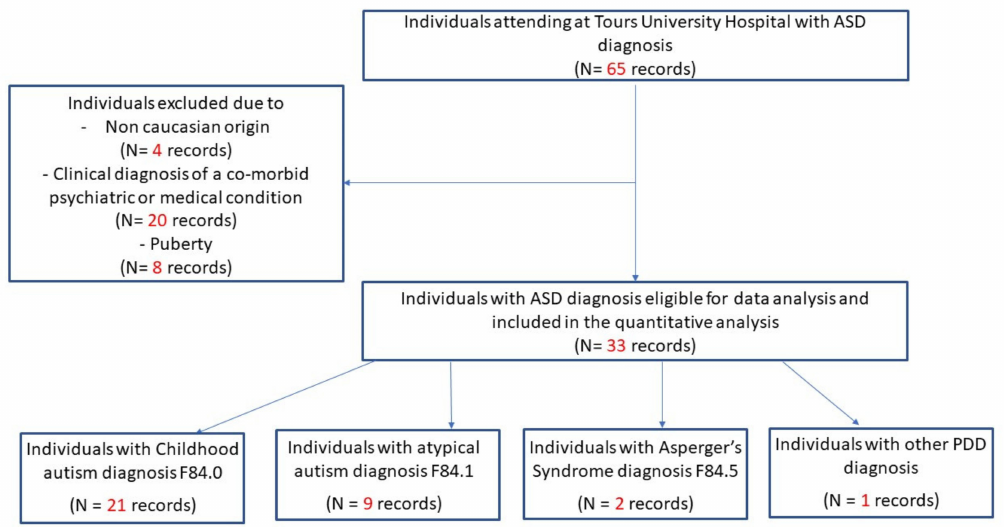
Figure 1. Flow-chart diagram of subjects’